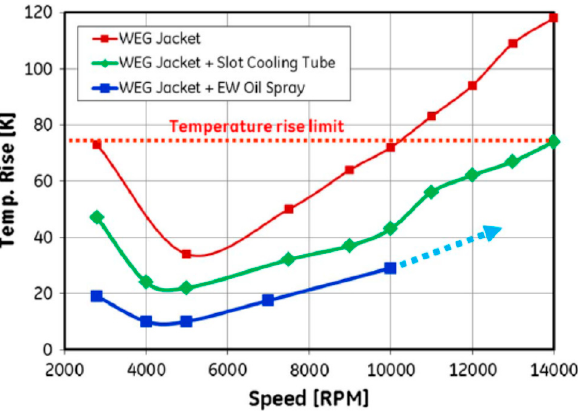
Figure 23. Rise in temperature with cooling schemes under 30 kW rated power [68].